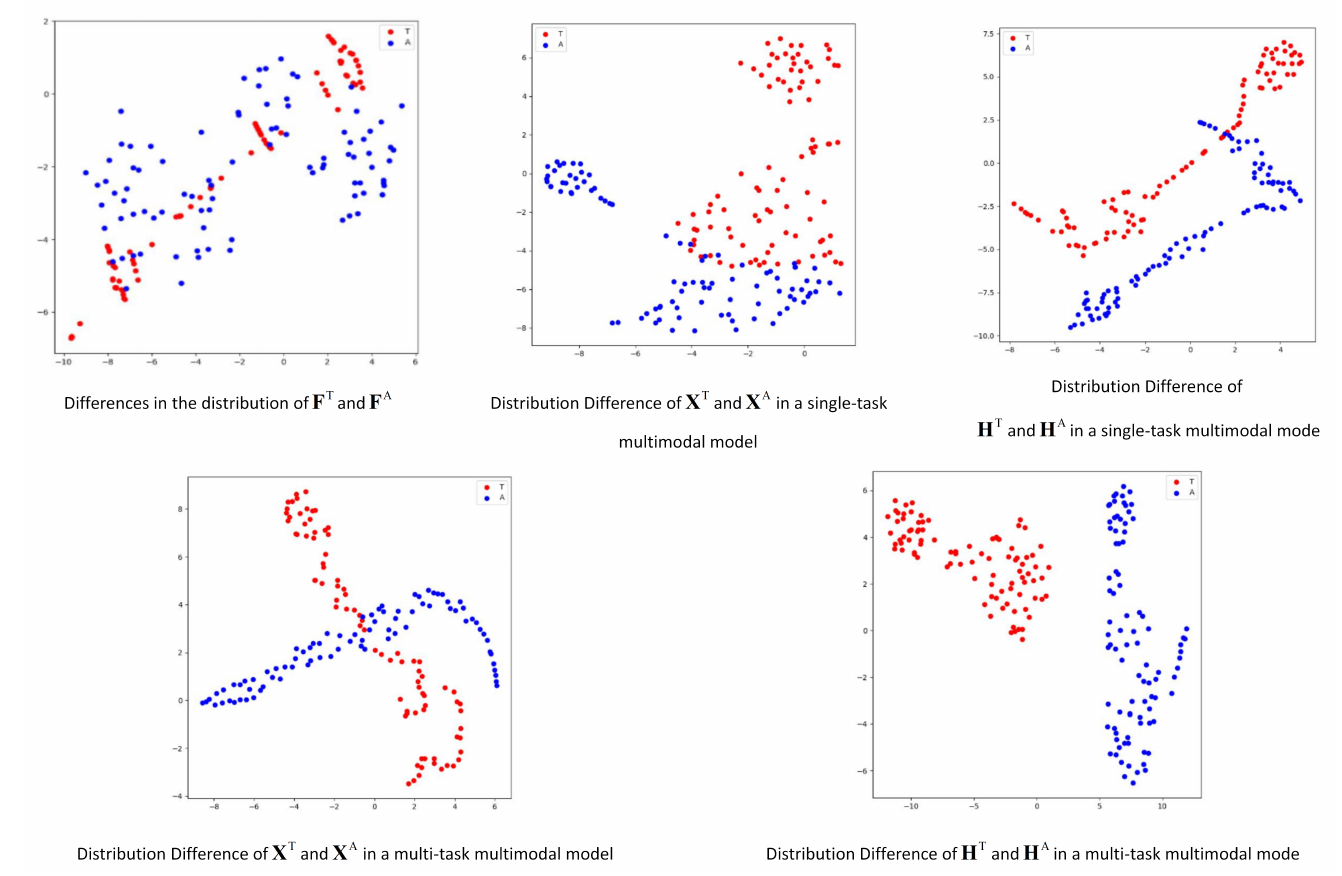
Figure 3. The different modal representations obtained at different stages of the single-task and multi-task multimodal models; the red dots and blue dots represent the single-modal characteristics of text and audio